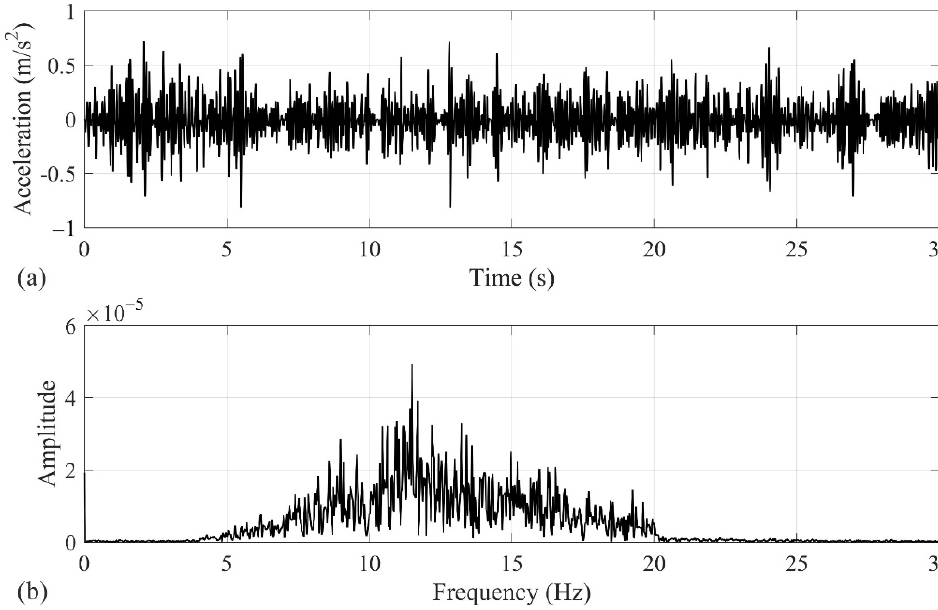
Figure 12. Base excitation signal: ( a ) Acceleration; ( b ) FFT spectrum. Table 6. Different beam lengths and their corresponding frequency tuning ratios.